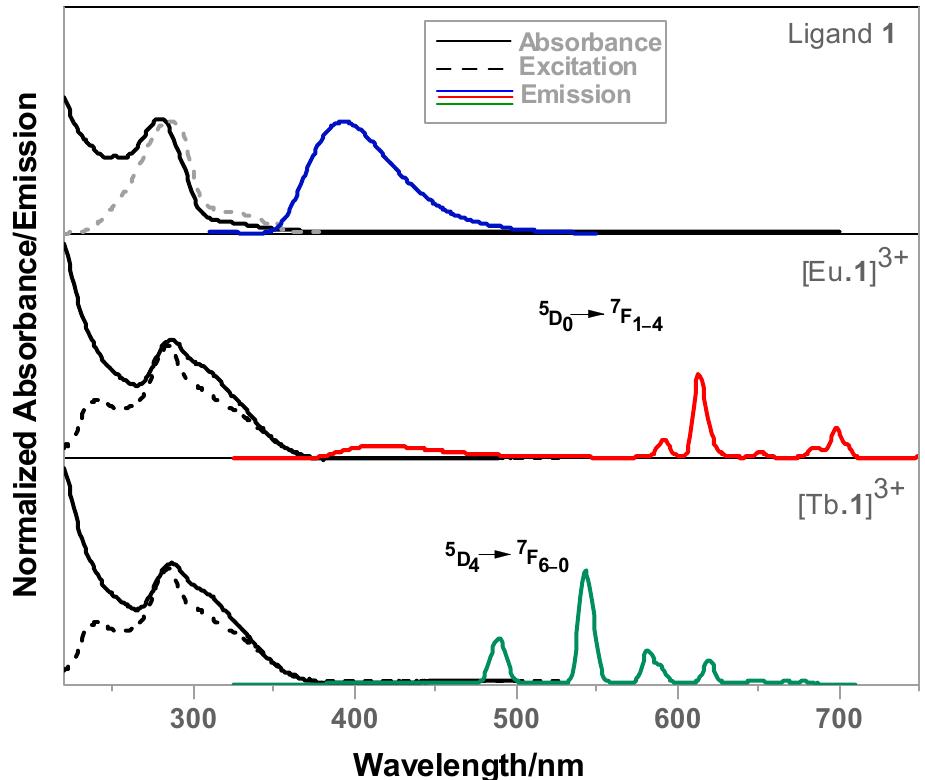
Figure 3. Normalized absorbance, excitation and fluorescence spectra of [Tb. 1 ](OTf) 3 (9.9 µM, acetonitrile) shown alongside the normalized ligand absorbance. Fluorescence spectrum conditions: emission: excitation at 280 nm; excitation: emission wavelengths: 394 (ligand), 543 (Tb) and 613 nm (Eu).